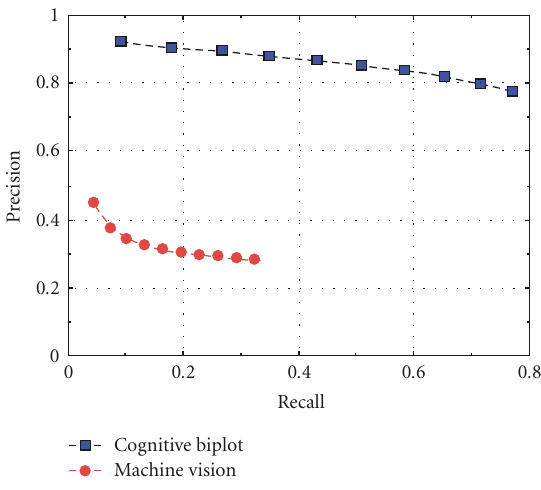
Figure 10: Comparison of the retrieval performance via the preci- sion versus recall diagram for the two di ff erent